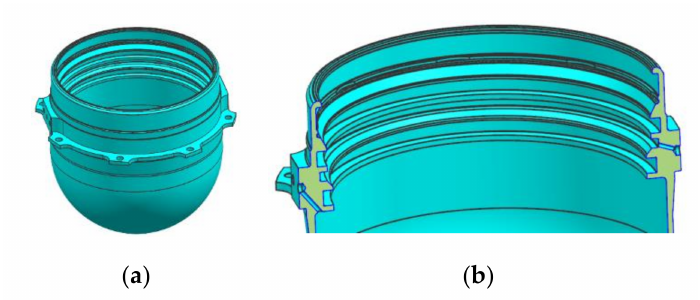
Figure 5. Vault design: ( a ) isometric view, ( b ) section through the leakage ports.